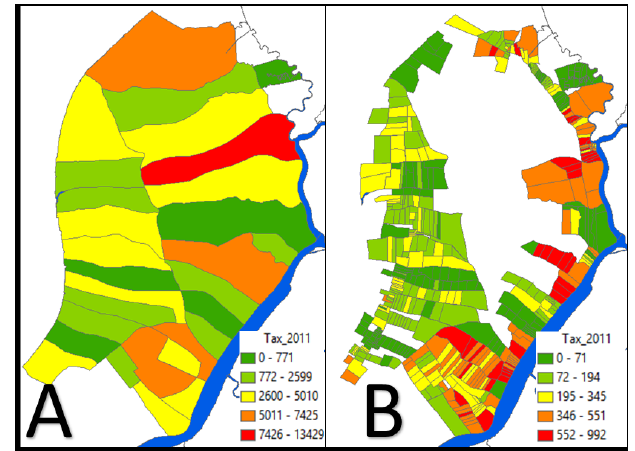
Fig. 13. Tax Registration database visualized in village boundary base map (A) and RT boundary base map (B) As aforementioned, the smallest administrative